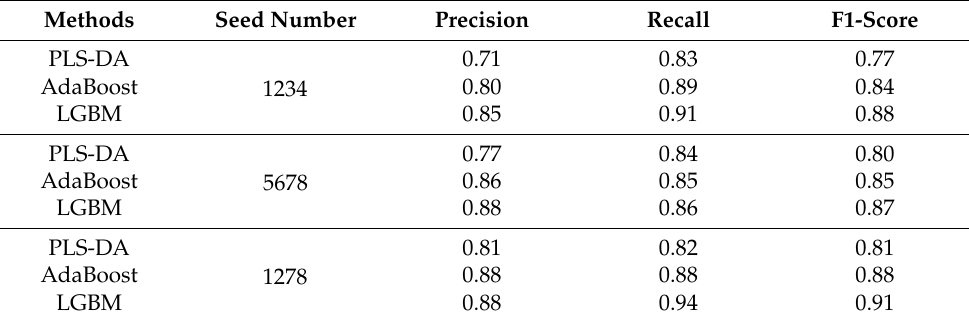
Table 1. The precision, recall, and F1-score values of the established models for Caco-2 properties. Methods